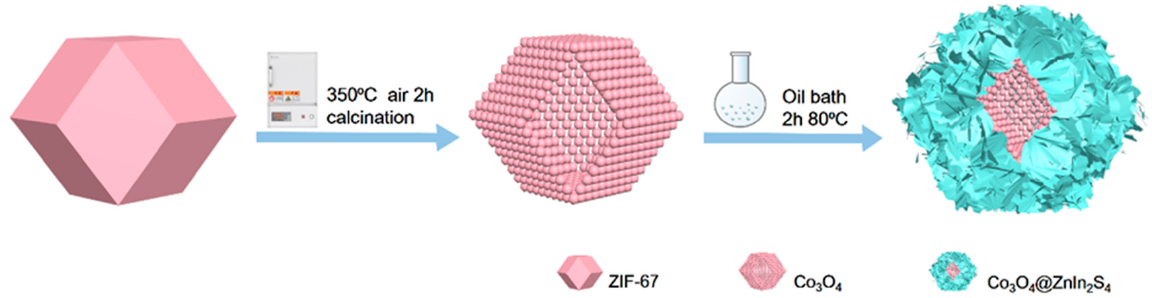
Figure 1. Scheme of the formation of the ZnIn 2 S 4 @Co 3 O 4 p-n heterojunction.